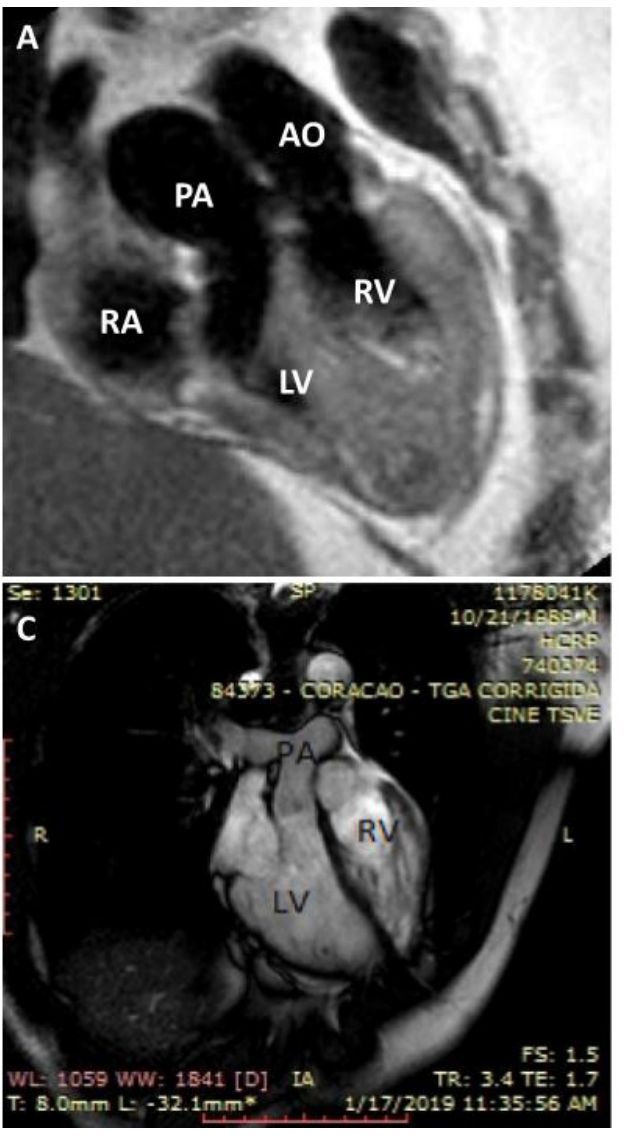
Fig. 3 - Magnetic resonance aspects of four patients with congenitally corrected transposition of the great arteries. A) Mildly symptomatic 50-year-old patient with moderate-severe tricuspid regurgitation (TR) showing discordant right-sided atrioventricular connection and bilateral discordant ventriculoarterial connections; B) symptomatic 69-year-old patient with large ventricular septal defect (VSD) plus severe pulmonary stenosis (blue arrow); C) asymptomatic 29-year-old patient with mild TR; D) 31-year-old patient with a mesocardiac heart after atrial septal defect closure and tricuspid valve replacement (same patient of Figure 7). AO=aorta; LV=left ventricle; PA=pulmonary artery; RA=right atrium; RV=right